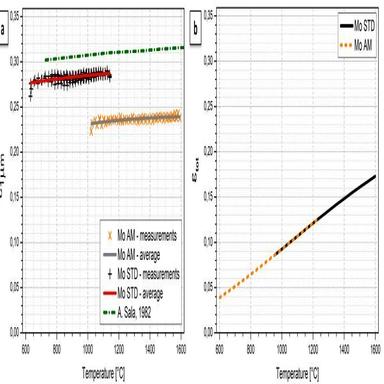
Spectral emissivity at 1 µm for both standard Mo (Mo STD) and Mo AM compared with available literature data (a) and the corresponding global emissivities (b).